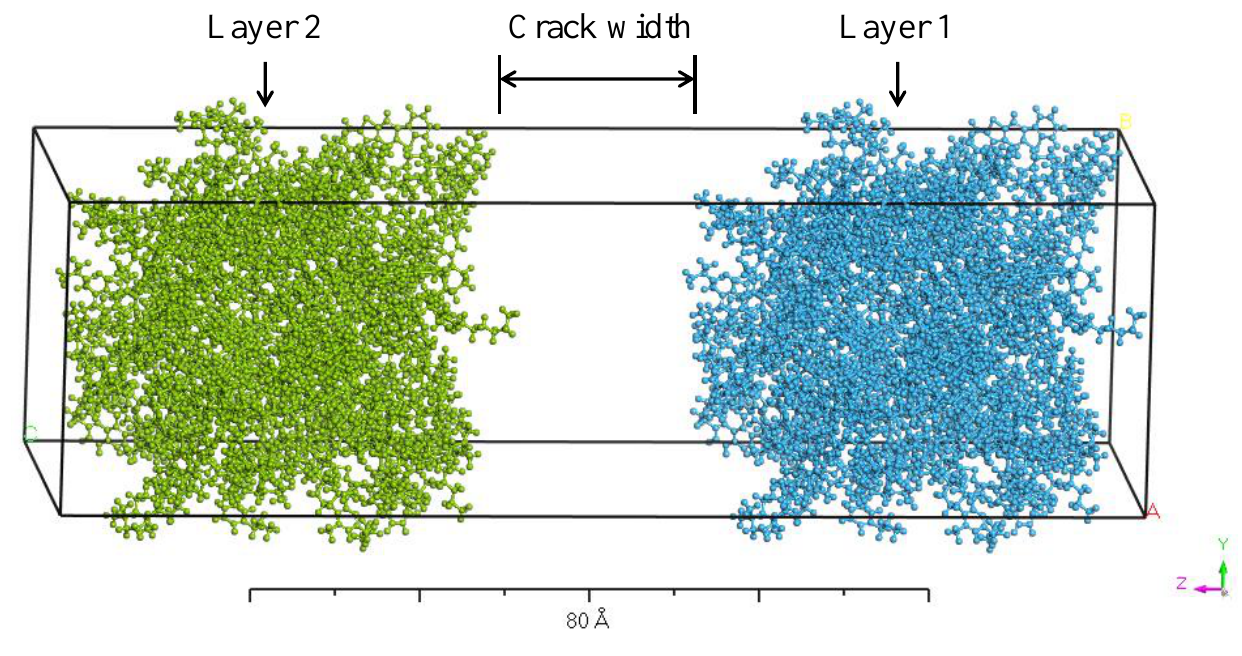
Figure 4. Self-healing model of asphalt